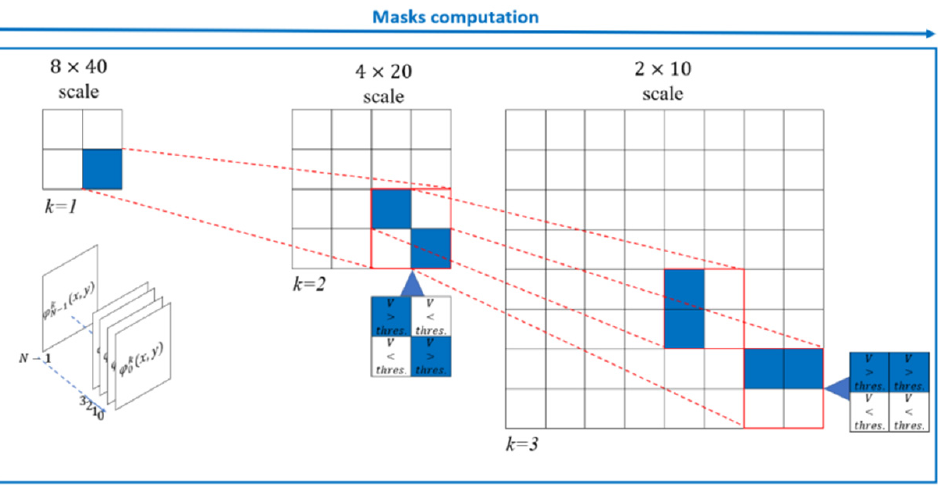
Figure 9. Scheme of the multi-resolution (multi-scale) phase unwrapping processing procedures. An adaptive quad-tree-like decomposition strategy is adopted.